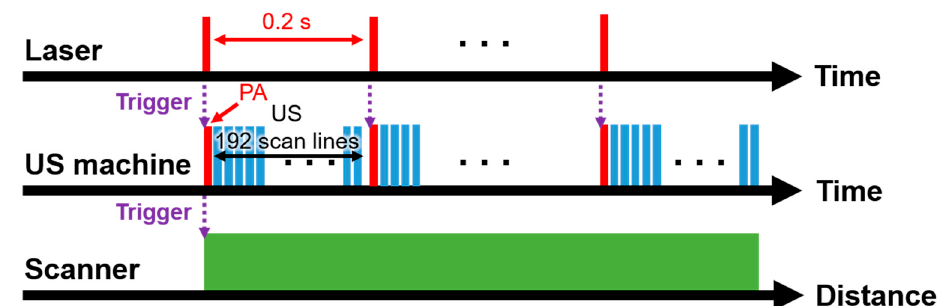
Figure 2. Data acquisition sequence of the dual-modal photoacoustic and ultrasound imaging system with a solid-state dye laser (SD-PAUSI). PA, photoacoustic; US, ultrasound.